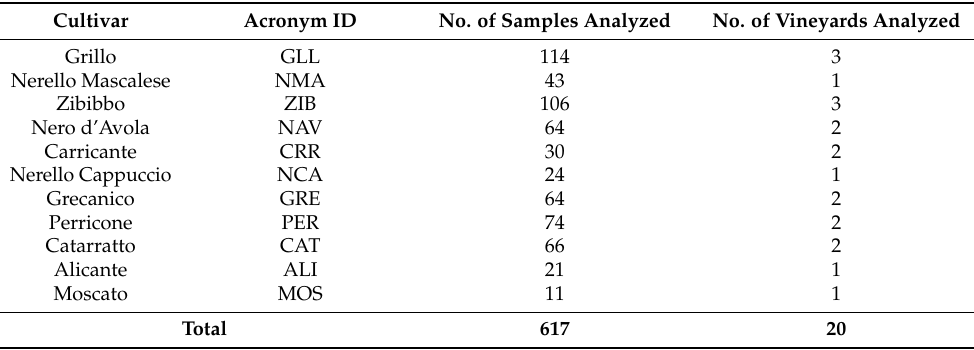
Table 1. Number of samples for each cultivar analyzed by DAS-ELISA for GVA.